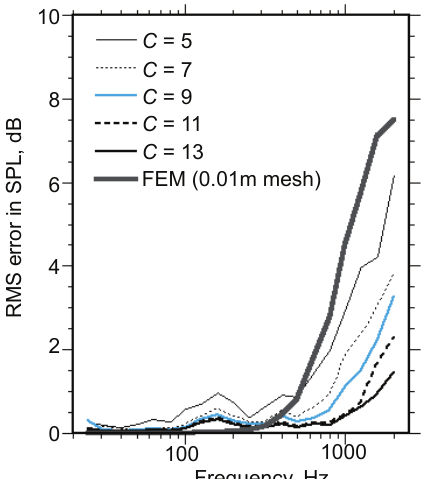
Figure 10. Comparison of RMS errors among results with different values of C : The standard FEM results obtained using 0.01 m mesh are also